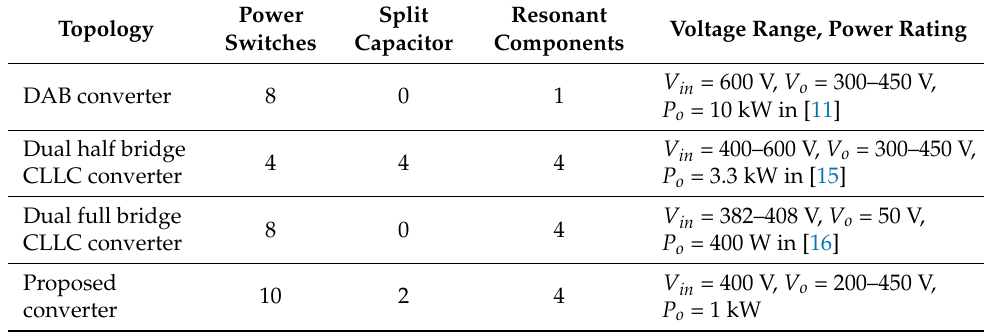
Figure 16. Picture of the prototype circuit. Table 1. Comparisons between DAB converter, CLLC converter, and the studied converter.